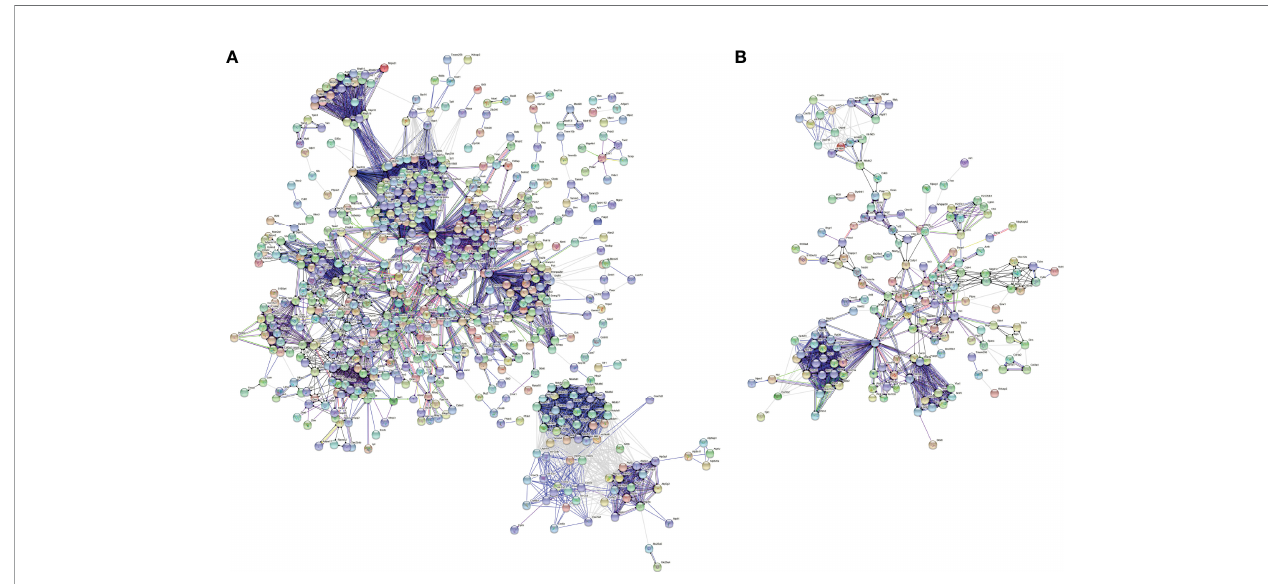
FIGURE 6 | PPI network analysis of speci fi c genes between fi brotic and regenerative myo fi broblasts or macrophages. (A) The PPI network of speci fi c genes between fi brotic and regenerative myo fi broblasts. (B) The PPI network of speci fi c genes between fi brotic and regenerative macrophages.